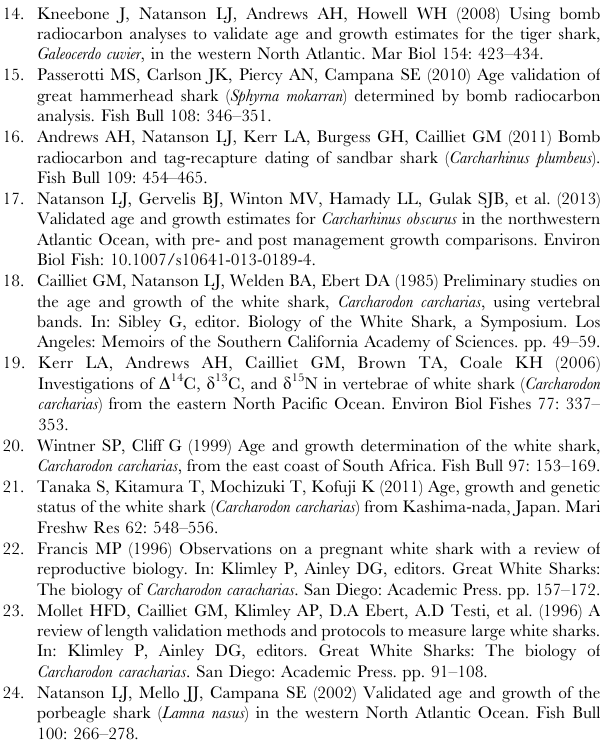
Figure S1 Linear trends fit to the D 14 C rise portion of the reference chronologies. A) Florida coral reference chronology, used to correct WS134. B) NWA otolith reference chronology, used to correct WS81 and WS105. Table S1 Phase lagged D 14 C shark values.